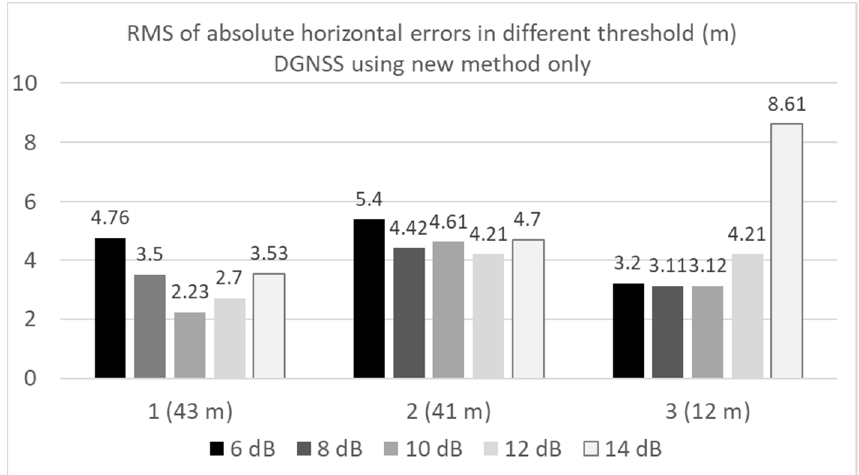
Figure 24. Comparison of DGNSS RMS errors in different periods.